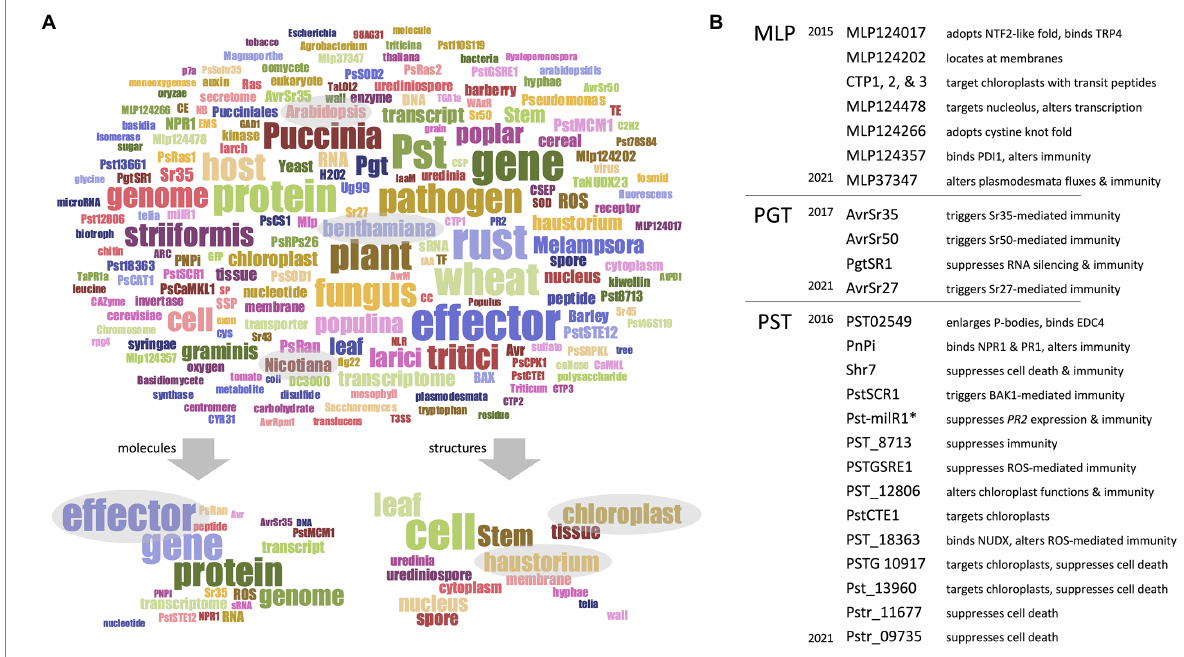
FIGURE 2 Pucciniales genomes facilitated the functional characterization of effector proteins. (A) Upper panel – word cloud displaying the most frequently appearing words referring to group of – or individual – molecules, organisms, and structures. The word cloud was built by using a filtered text file comprising RPGs title and abstract deprived from words not explicitly referring to molecules, organisms, or structures. The word cloud displays 200 words; the size of the words positively correlates with their frequency in the text file. Word colors are meaningless; they simply assist reader visual word discrimination. (A) Lower panel – subordinate word clouds highlighting the words referring to molecules (leaf-hand side) or structures (right-hand side). Gray ovals emphasize words discussed in the main text. (B) List of effector proteins collectively investigated by the RPGs, grouped according to their rust fungal species, and sorted according to the date of publication of the corresponding RPG reporting their characterization. MLP, Melampsora larici-populina ; PGT, Puccinia graminis f. sp. tritici ; PST, Puccinia striiformis f. sp. tritici . The asterisk indicates the non-proteinaceous, small RNA effector Pst-milR1. A short summary accompanies each effector, to inform on the main findings obtained by the functional studies. The raw data used to build this figure are available in Supplementary Dataset 1 (columns Q–W) and Supplementary Dataset